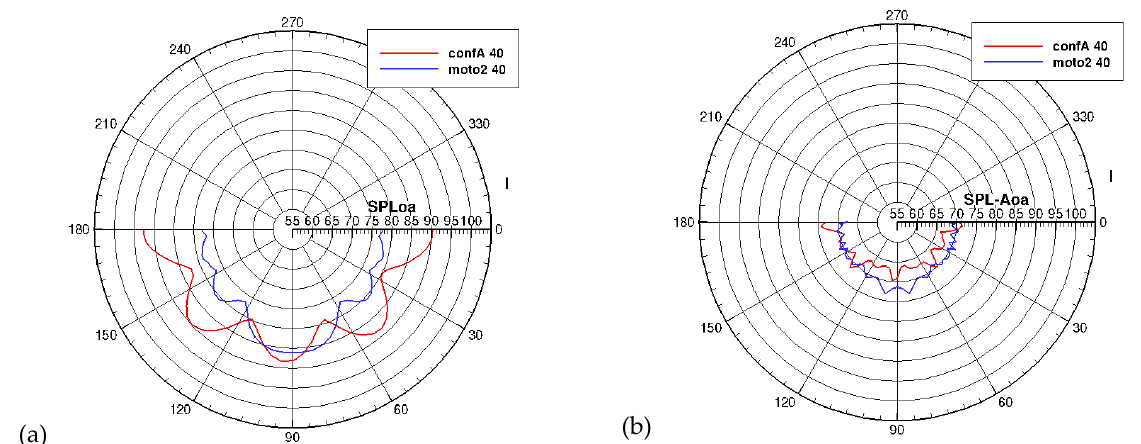
Figure 28. Comparison between Configuration A and Motorization 2; OASPL values on the transverse YZ plane ( a ), A-weighted values on ( b ). Flight condition Descent 40% ETR.